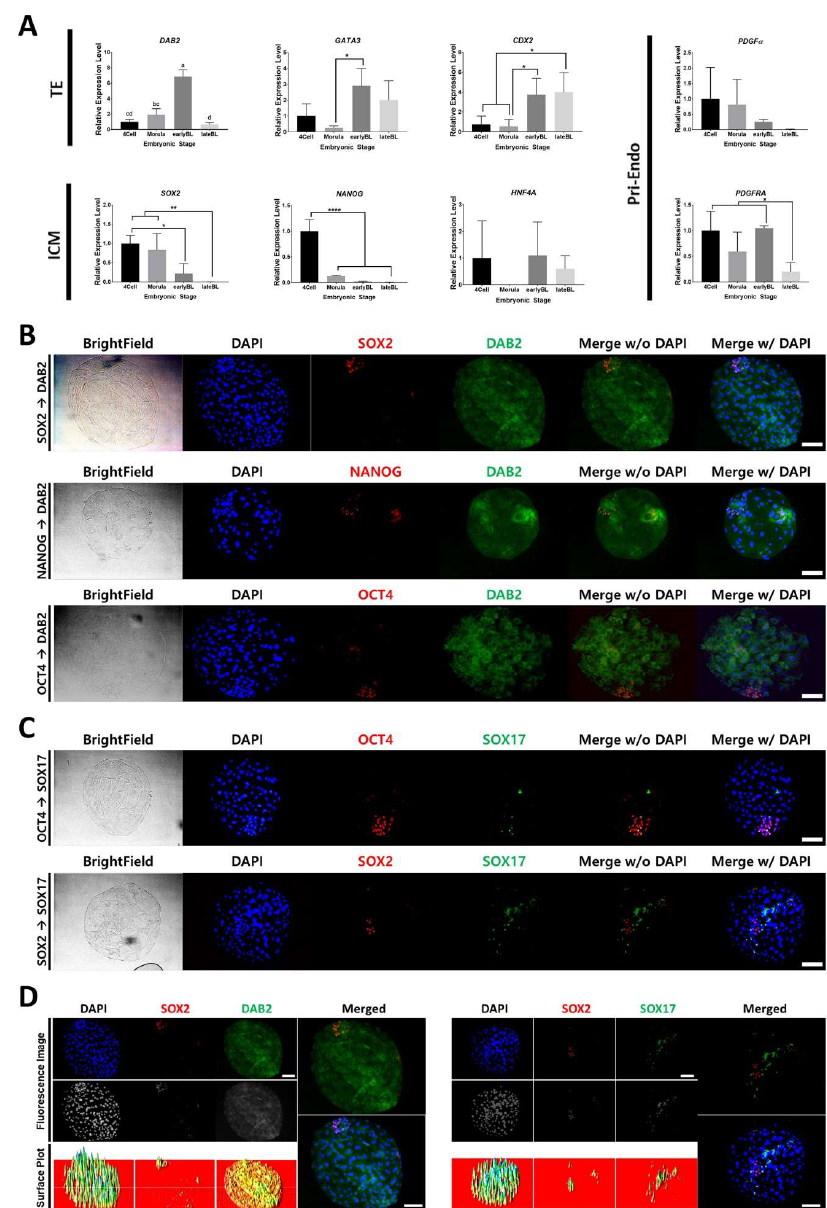
Figure 1. Marker mRNA levels in embryonic stages and marker protein distribution in day 7 blastocyst. ( A ) Expression levels of well-known lineage markers (Trophectoderm (TE); DAB2 , GATA3 ,